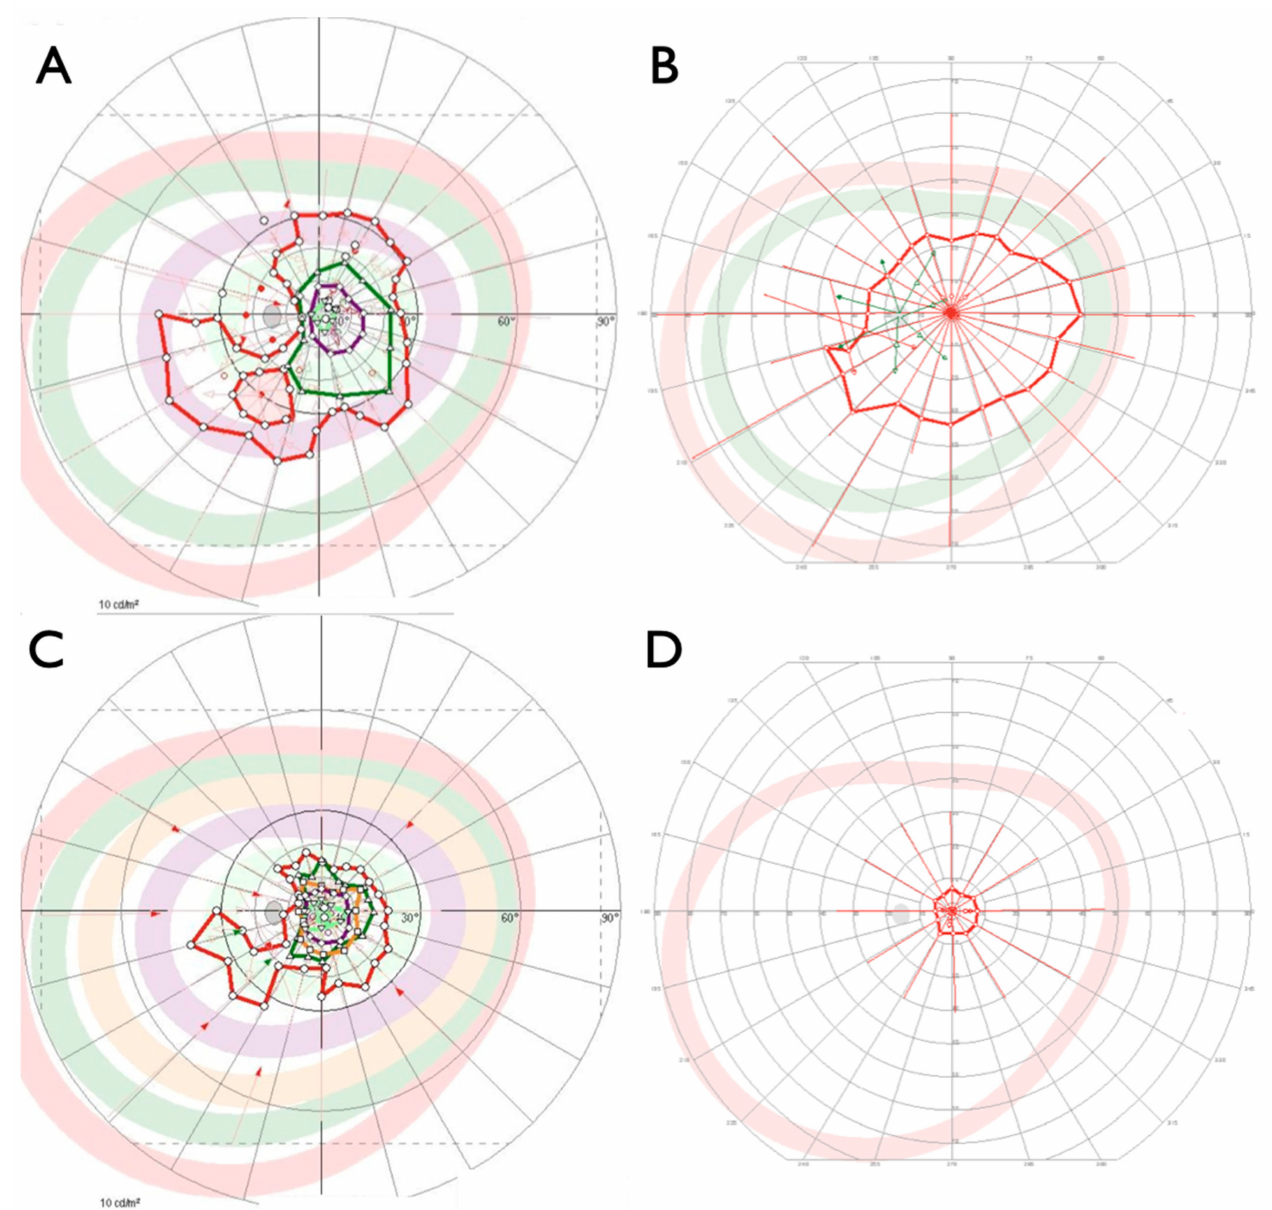
Figure 8. Visual fields in patient IV:1 ( A ), patient IV:2 ( B ) and patient IV:3 from family ADRP 386 at 50 ( C ) and 56 years of age ( D ). Please note that visual fields were obtained with different software and therefore cannot be displayed with the same look. Degrees are scaled similarly for all